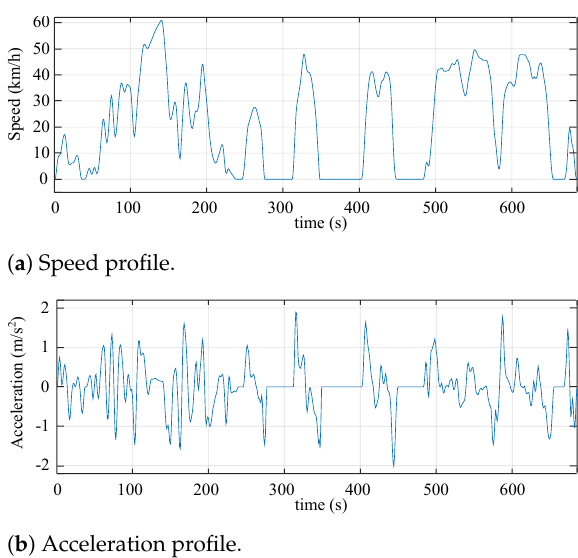
Figure 8. Fleet − BEV urban cycle